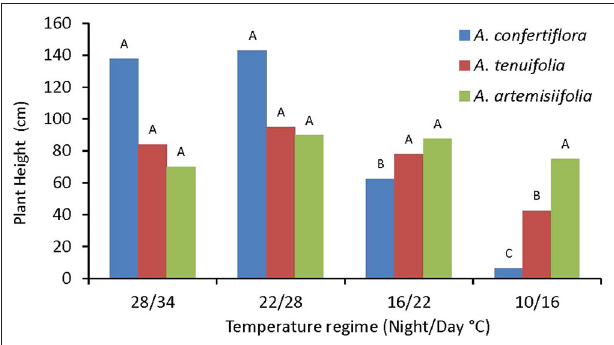
Frontiers in Agronomy |